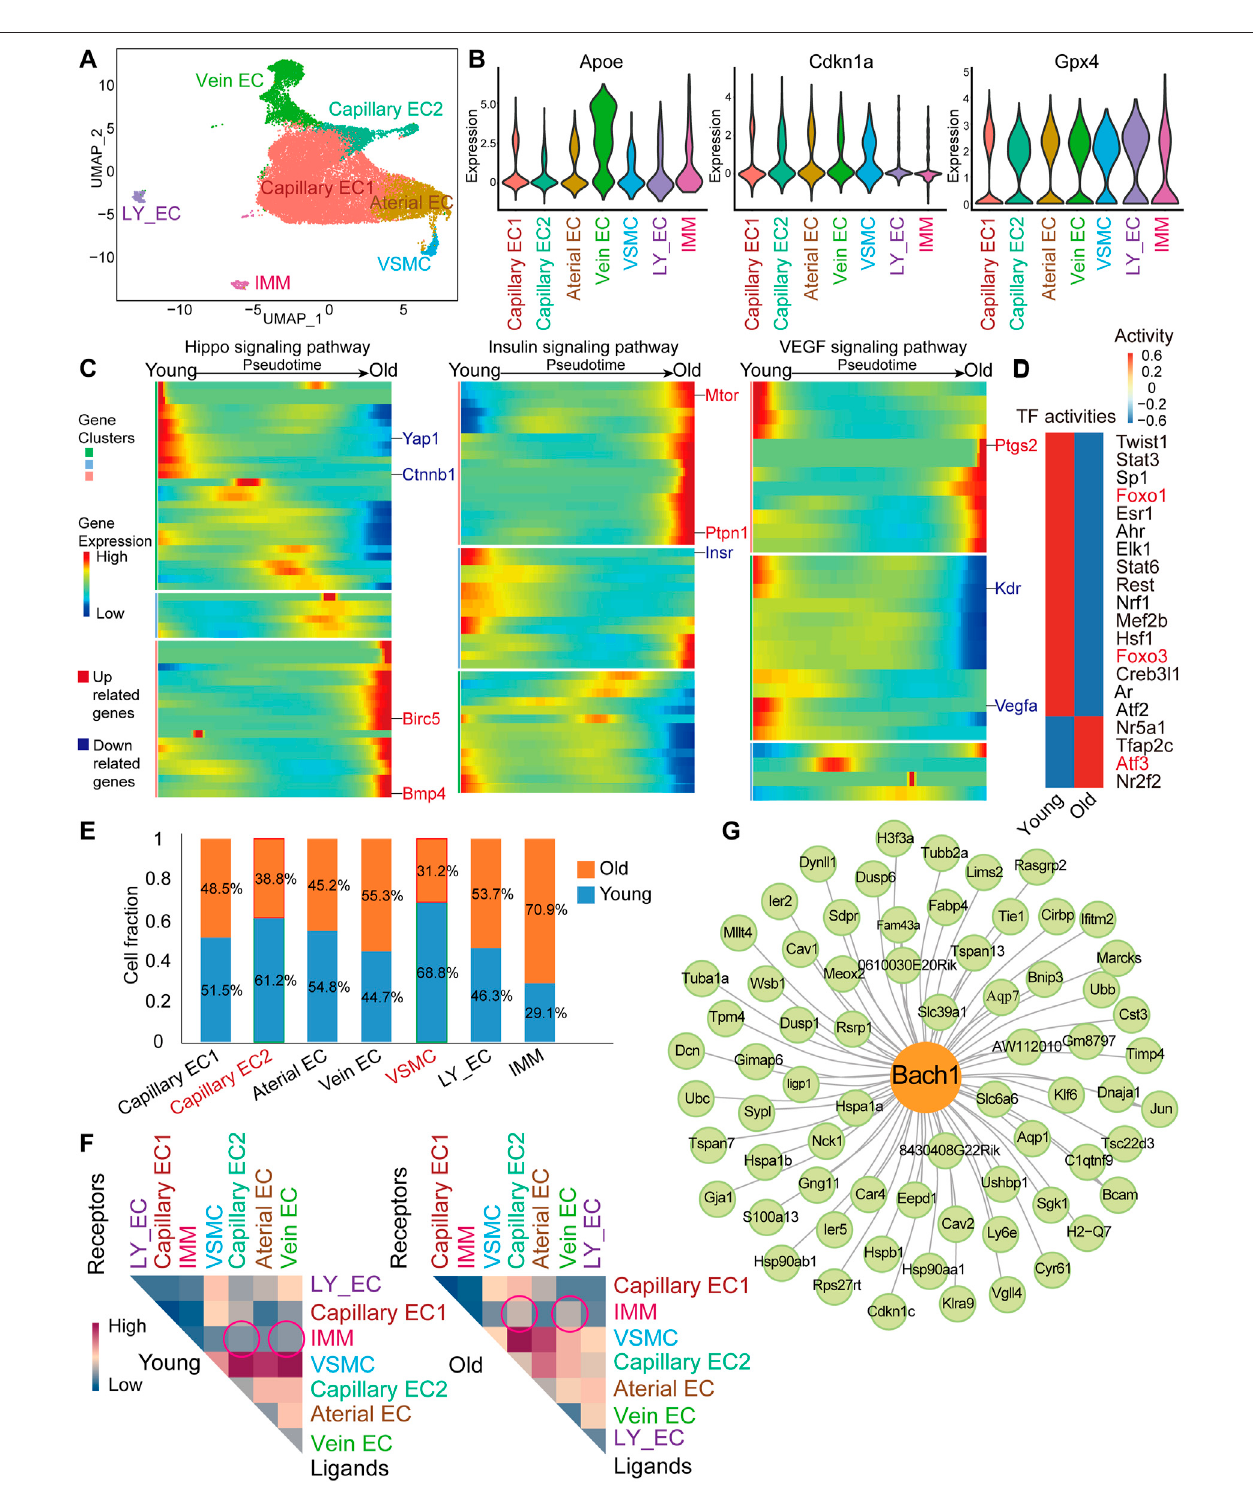
FIGURE2| scRNA-seqanalysisofyoungandoldmouseheartECs. (A) UMAPplotof26,385cellsforthemouseglobalcellpopulation.EC,lymphaticEC-likecells (LY_EC), vascular smooth muscle cell (VSMC), and IMM. (B) Violin plot of normalized expression of aging-related genes, Apoe, Cdkn1a, and Gpx4. (C) Pseudotime heatmapshowingrelativeexpressionofsignalingpathway-relatedgenesfromthestateofyoungtooldinCapillaryEC2. (D) HeatmapofselectedTFactivitiesinferredby DoRothEA between young and old mice. Red color genes are transcription factors (TFs) of interest. (E) Cell composition of seven Seurat clusters by age (young/ old). (F) Heatmap of mean interaction numbers of ligands and receptors between cell types. Rows represent ligands, and columns represent receptors. (G) Network visualizationofBach1-related regulationinEC clusters.Greennodes representold/youngDEGsofCapillary EC1,CapillaryEC2,ArterialEC,and VeinEC. Bach1shown as the yellow node.